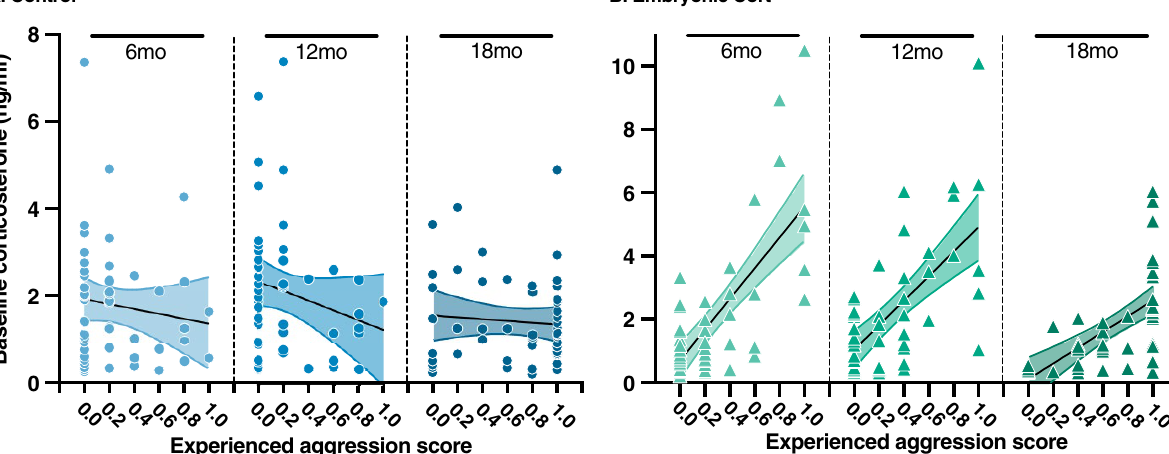
Figure 3. Cumulative experienced aggression score from the five weeks prior to the stress series plotted against baseline corticosterone at 6, 12, and 18 months for ( A ) control birds and ( B ) birds treated with 5 ng embryonic corticosterone. Linear regression lines for each treatment with 95% confidence intervals are plotted for each age.